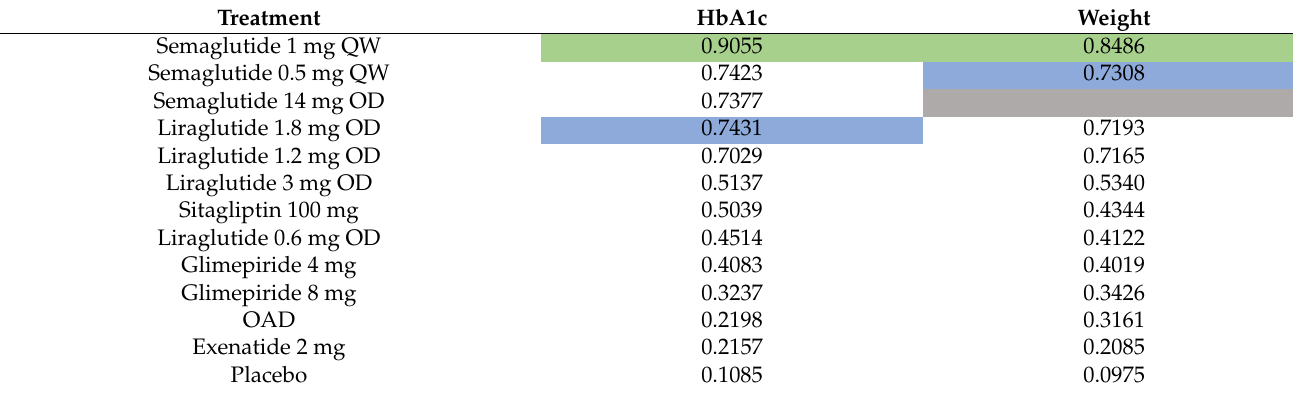
Table 5. Surface under the cumulative ranking curve (SUCRA) values for each intervention.